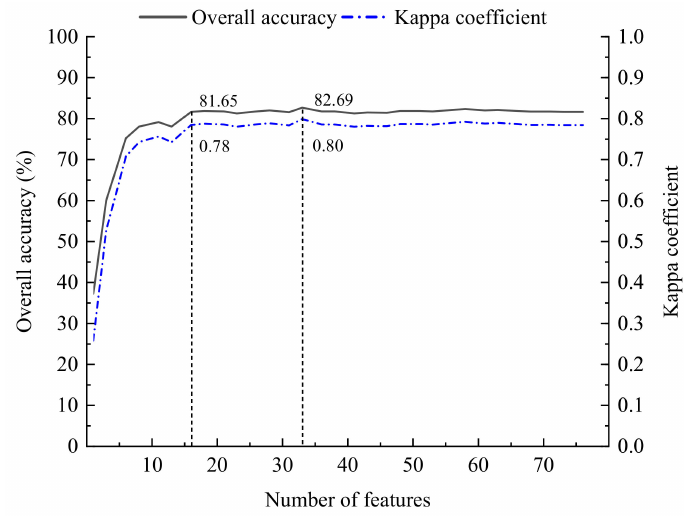
Figure 4. Classification results for the different feature